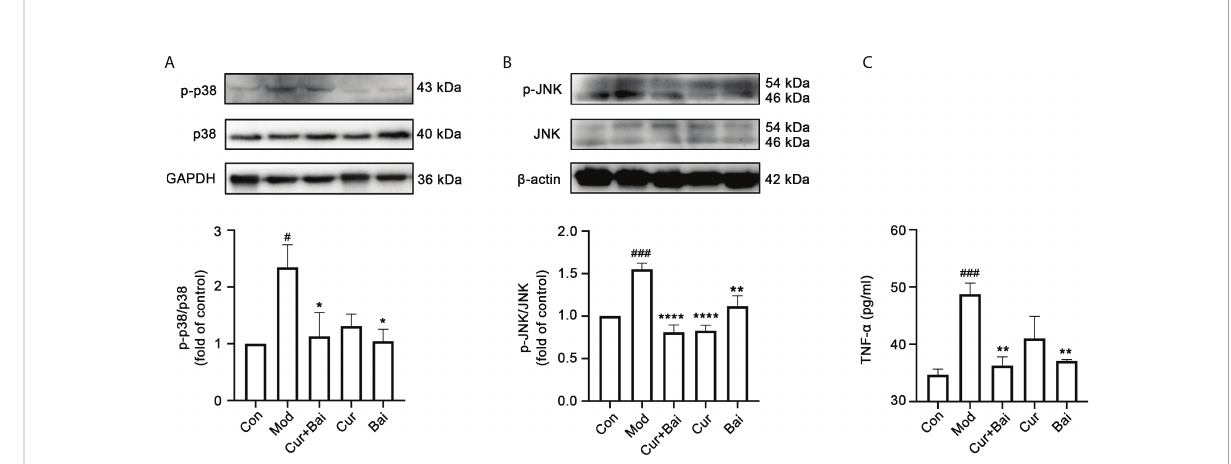
FIGURE 7 The treatment of Cur+Bai downregulated phosphorylated MAPKp38 and JNK, and reduced the production of TNF- a in the entire aorta wall in the diabetic rats. (A) Cur+Bai and Bai downregulated phosphorylated MAPKp38 expression in diabetic rats as analysed by the Western blot analysis. n=3, # p <0.05 vs. control group, * p <0.05 vs. model group. (B) Cur+Bai, Cur and Bai downregulated phosphorylated JNK expression in diabetic rats as analysed by the Western blot analysis. n=3, ### p <0.001 vs. control group, ** p <0.01, **** p <0.0001 vs. model group. (C) The treatment of Cur+Bai downregulated the TNF- a production expression in the diabetic rats. n=5, ### p <0.001 vs. control group, ** p <0.01 vs. model group. Results were expressed as mean ± SEM for fi ve rats per group. The p values were obtained from one-way ANOVA